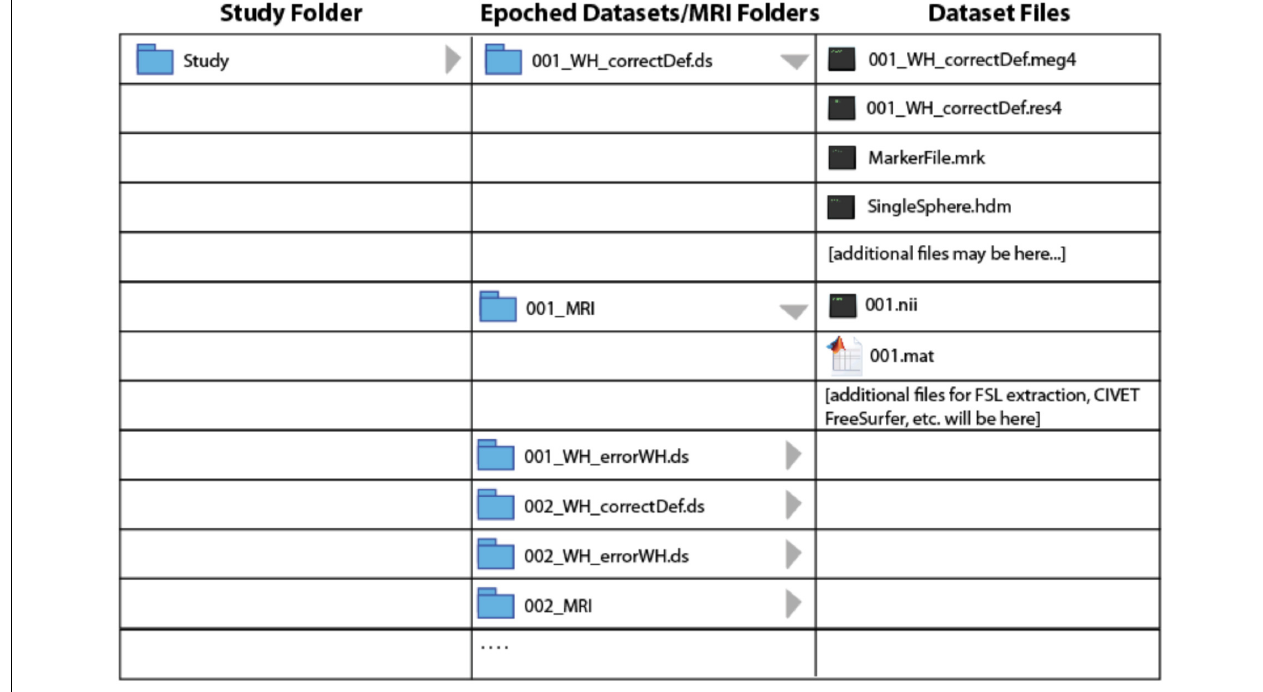
FIGURE 1 | Data structure. MEG dataset and MRI directory file structure used by BrainWave